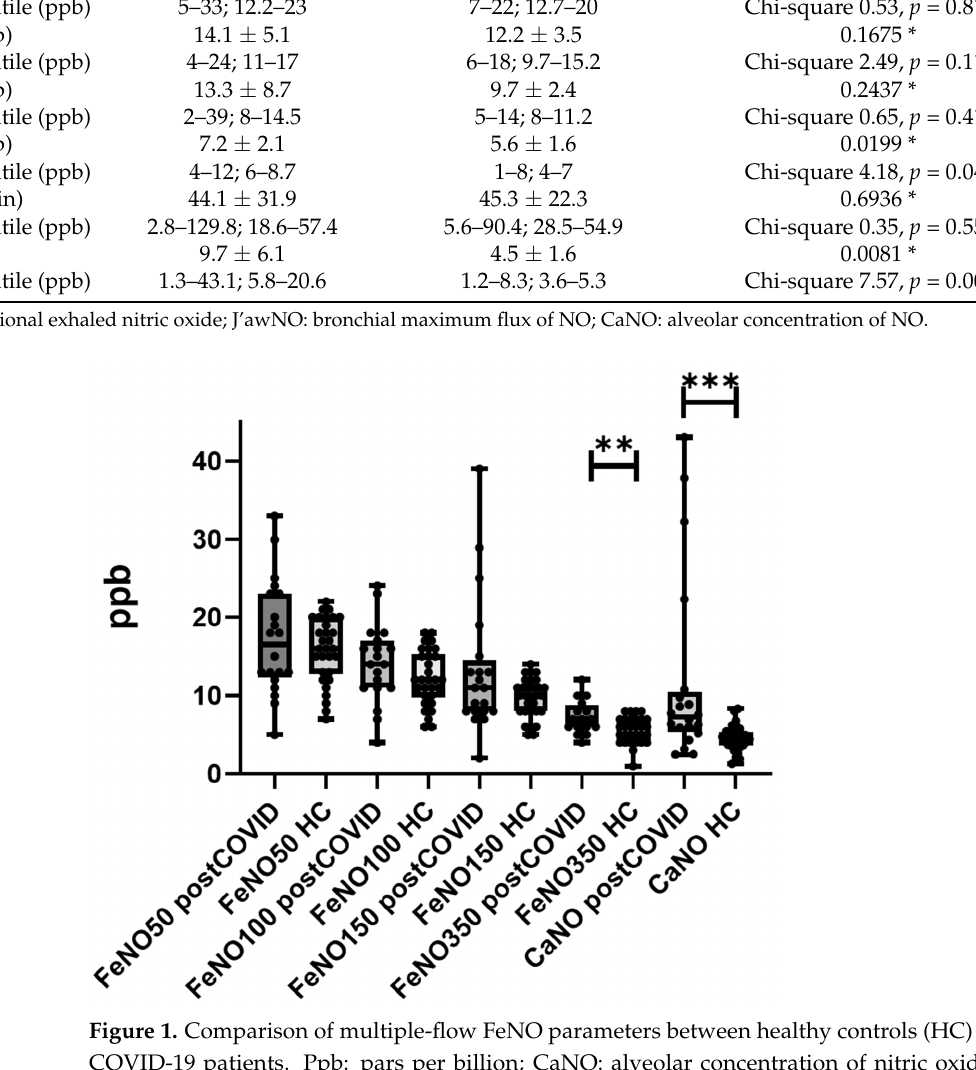
Figure 1. Comparison of multiple-flow FeNO parameters between healthy controls (HC) and post- COVID-19 patients. Ppb: pars per billion; CaNO: alveolar concentration of nitric oxide; FeNO: fractional exhaled nitric oxide; **: p = 0.019; ***: p = 0.0081.